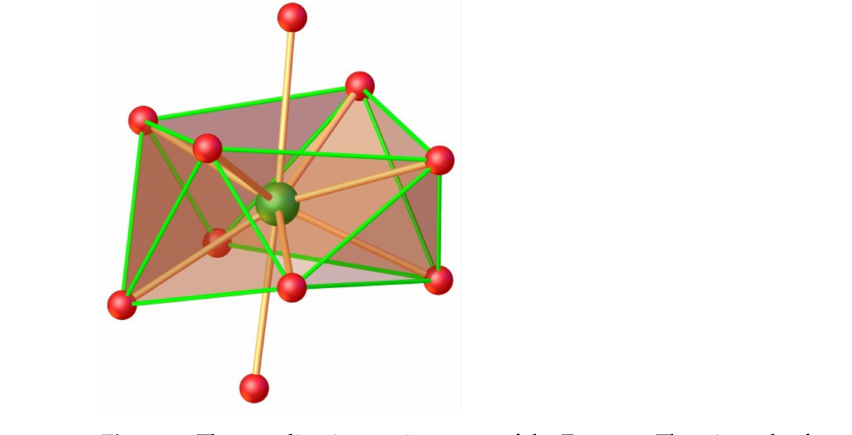
Figure 6. The coordination environment of the Eu atom. The triangular faces of square antiprism are drawn with green